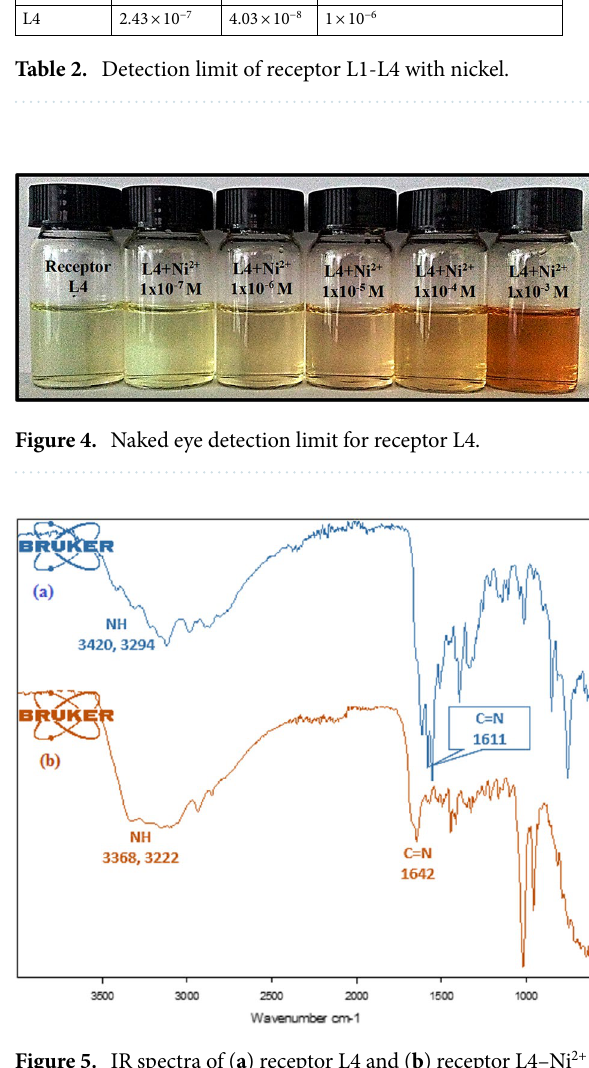
Figure 5. IR spectra of ( a ) receptor L4 and ( b ) receptor L4–Ni 2+